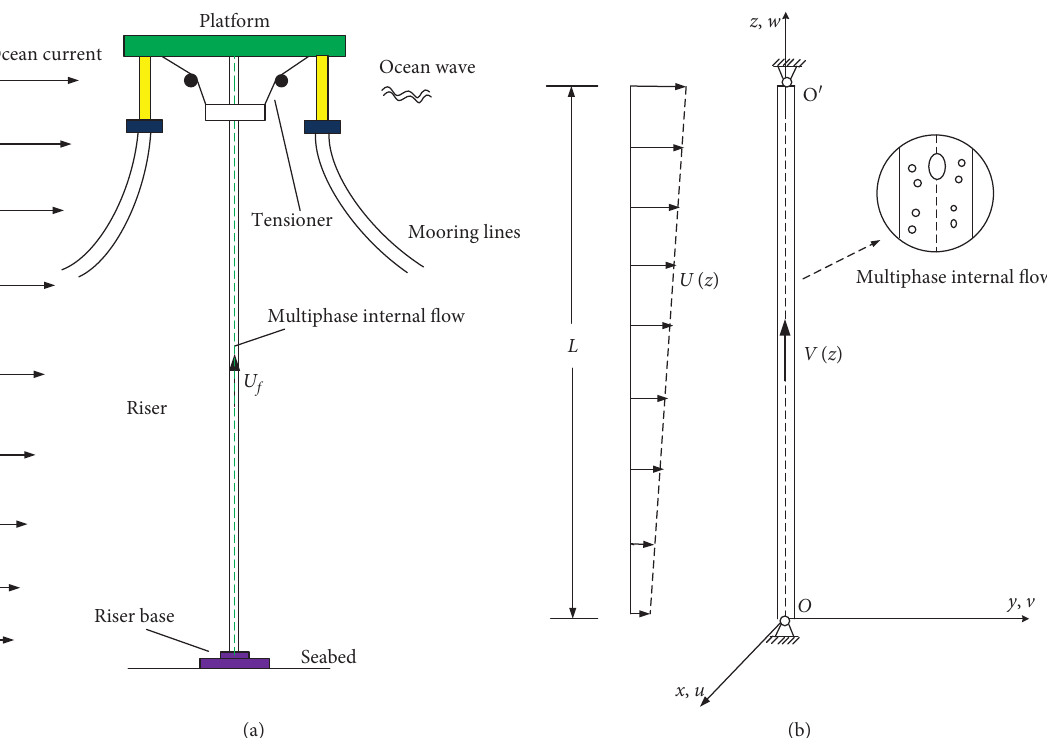
Figure 1: A schematic 3D model of a marine riser system subjected to two-phase internal flow and its simplified